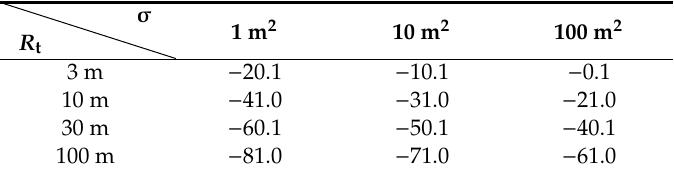
artificial target with a constant RCS at specific ranges.